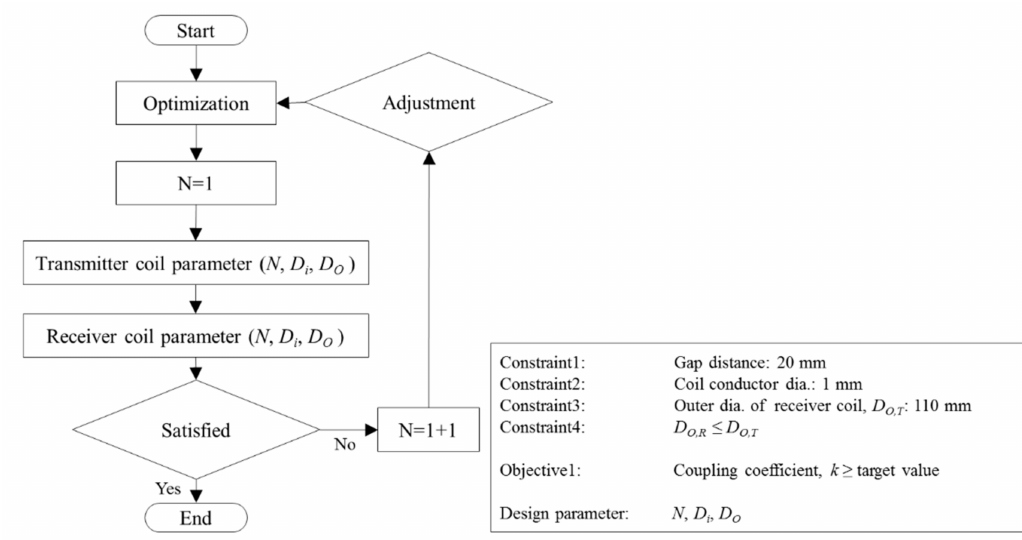
Figure 5. Design method of the transmitter coil and receiver